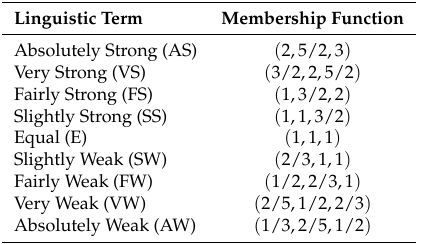
Figure 1. Modified Fuzzy VIKOR reputation model for federated testbeds. Table 1. Linguistic terms and membership functions of fuzzy weights.